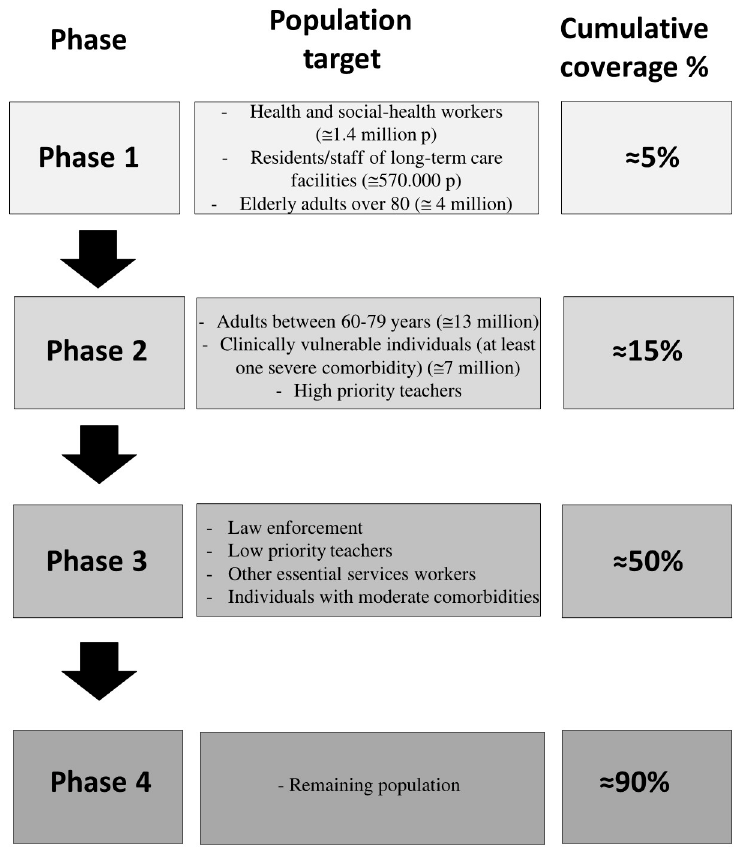
Figure 1. System level block diagram representing the Italian Vaccine distribution plan.